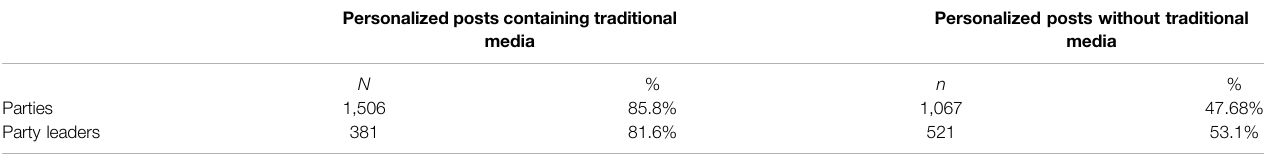
TABLE 3 | Personalization of social media posts with and without traditional media.